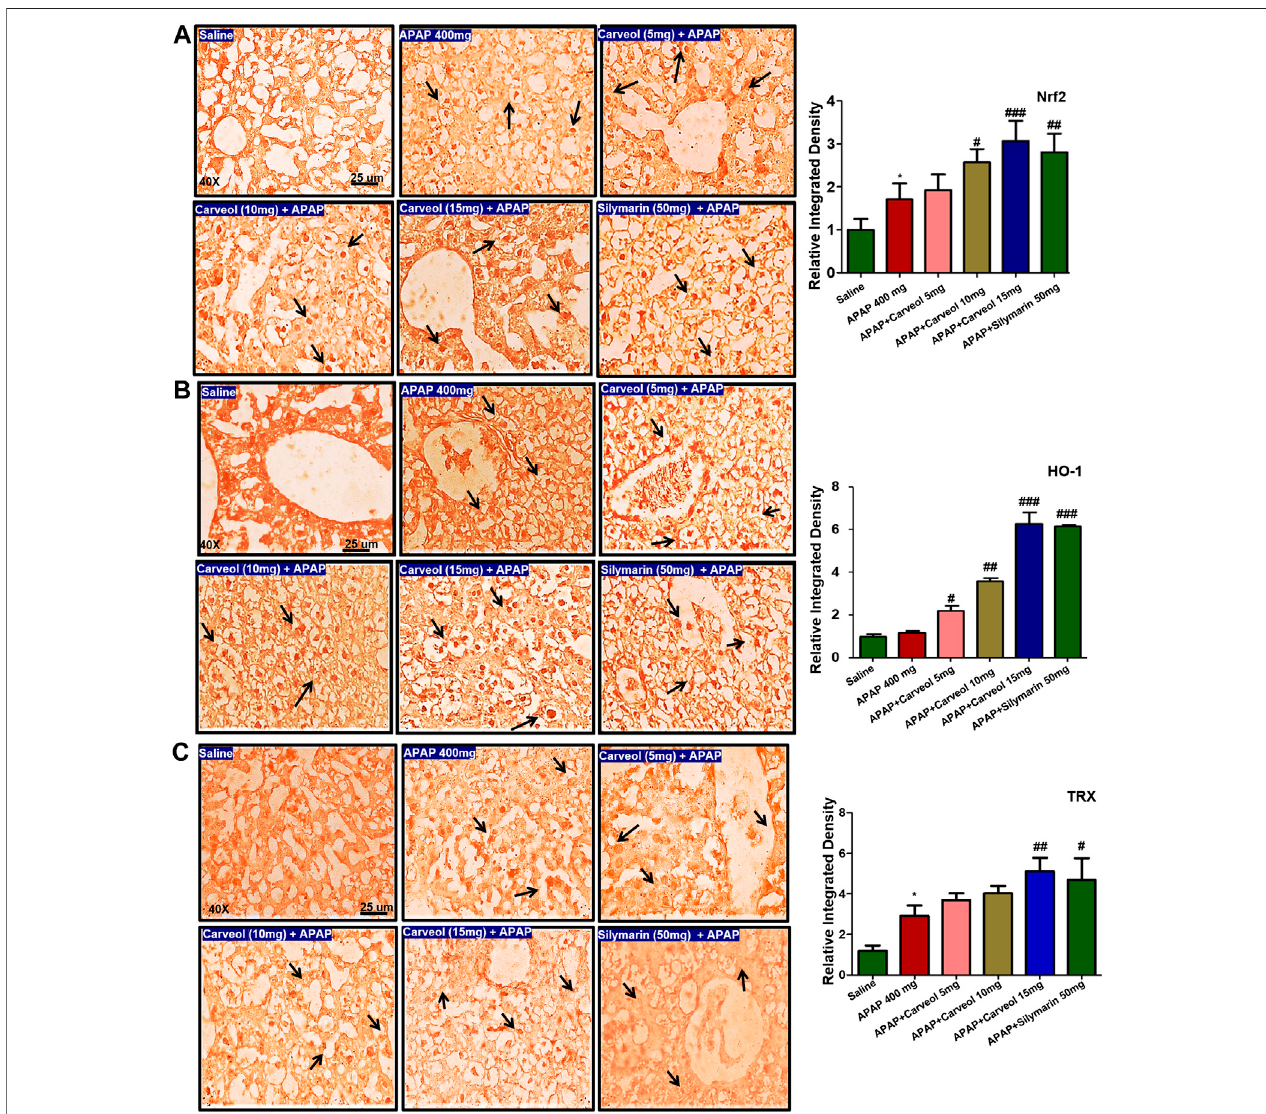
Figure 6 | Effect of carveol on immunohistochemistry expression (A) Nrf2 (B) HO-1, and (C) TRX with magni fi cation × 40, and scale bar (cid:1) 25 μ m, n (cid:1) 7/group. Representative histograms indicate a comparatively lower expression of (A) Nrf2 (B) HO-1, and (C) TRX in the APAP group than the carveol group. The data are presented as means ± SEM and were analyzed using one-way ANOVA followed by Tukey ’ s multiple comparison test. The symbols ### represent signi fi cant difference values of p < 0.001, while the symbol ## represents p < 0.01 values of signi fi cant differences, and p or # represents p < 0.05. # is signi fi cantly different from APAP.